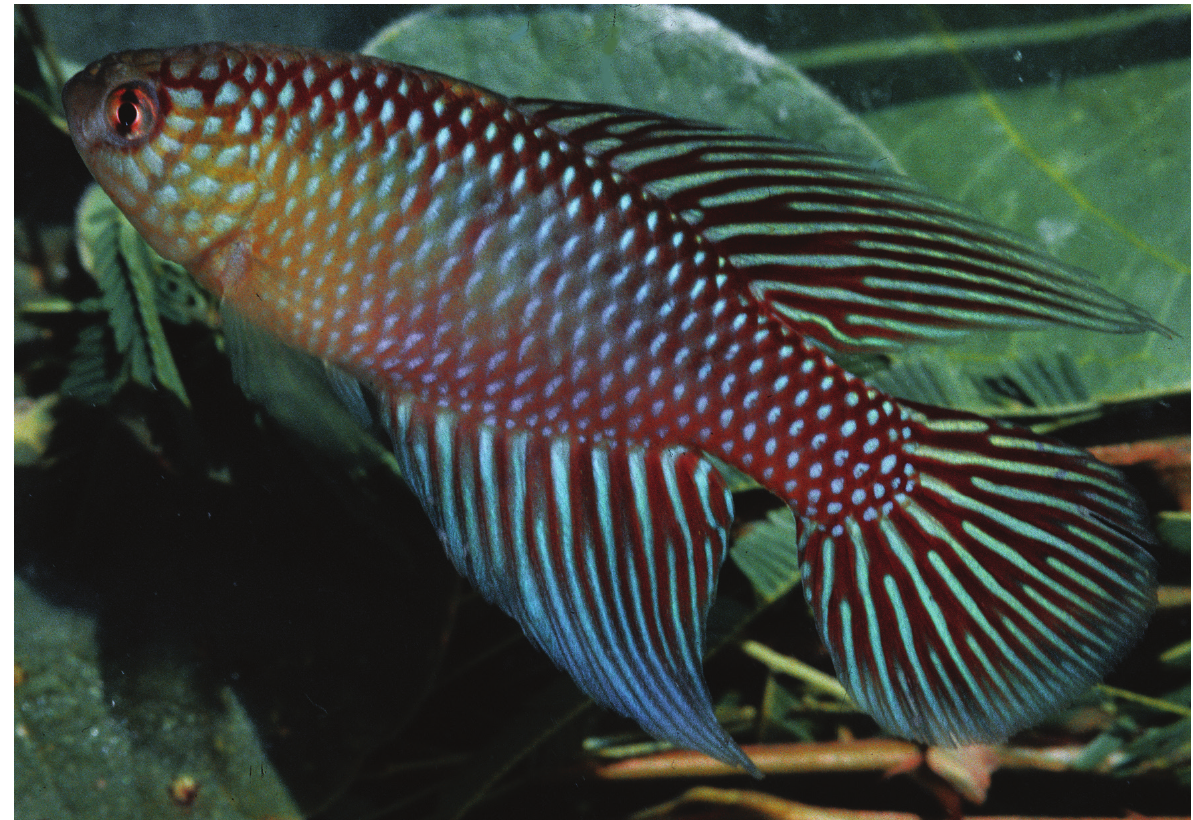
Figure 5. Hypsolebias fulminantis , UFRJ 4847, male, 44.0 mm SL. Photograph by W.J.E.M.